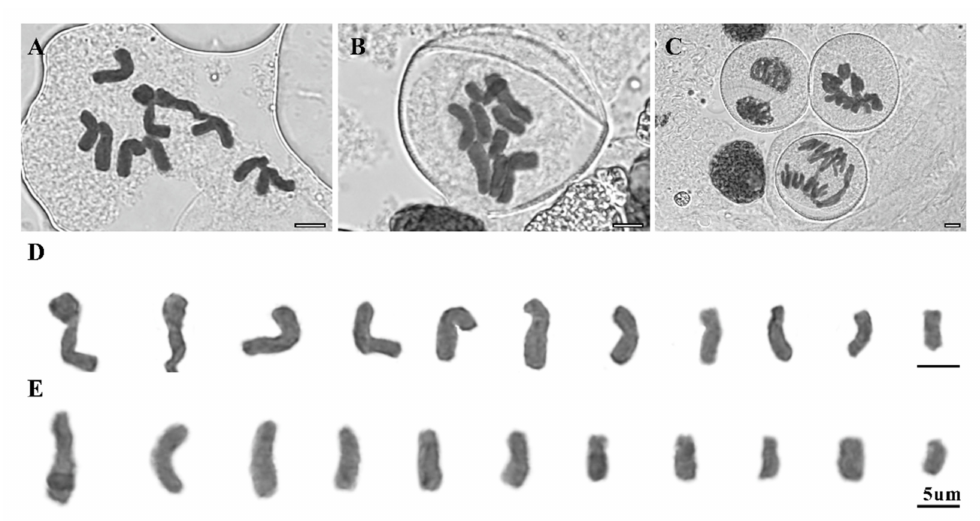
Figure 2. Meiotic chromosomes and karyotypes of Cypripedium japonicum . ( A , C , D ) collection number (population_individual): DY1_5, ( B , E ) collection number (population_individual): DY2_2, detailed information is given in Table